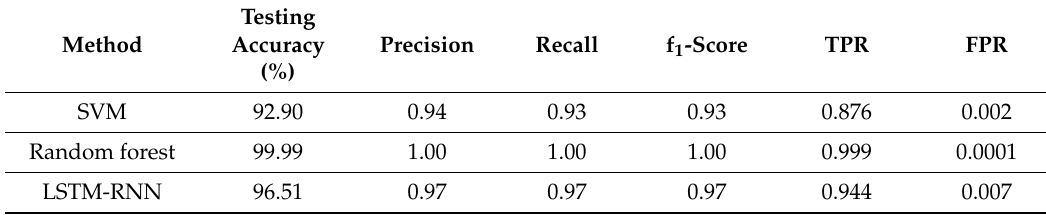
Table 10. Performance comparison for binary classification using 122